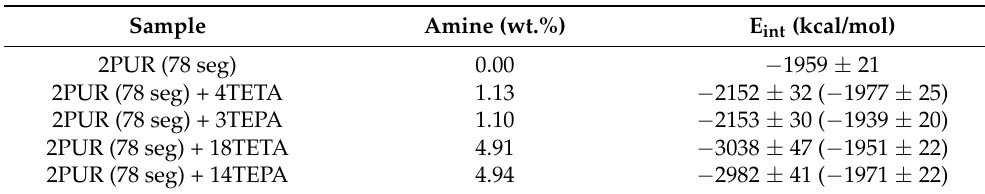
Table 3. Models of two PUR chains (78 segments each) with different amounts of amines expressed Figure 8. Mutual positions of PUR/TETA/TEPA corresponding to their maximum interaction energy by the number of molecules and weight percentages. The interaction energies ( E int ) of two PUR for two extreme mutual positions, i.e., parallel and crossed. The atoms of the functional groups chains with different amounts of amines are provided in the third column ( E int values for the same sharing hydrogen bonds are displayed as balls. For clarity, the carbon atoms in the amines are black. models without amines are provided in